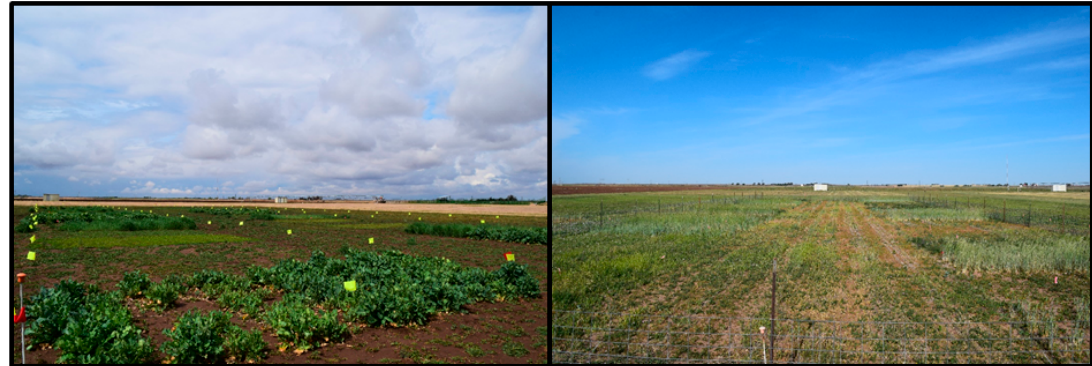
Figure 6. View of cover crop growing in the experimental plot area in Year 1 (spring 2016; left ) and Year 2 (spring 2017; right ). Crops grown included: rye (cv. Maton II), wheat ( Triticum aestivum L.; cv. TAM204), burr medic ( Medicago polymorpha L.; cv. Armadillo), hairy vetch (Vicia villosa Roth; cv. Vallana), rape kale ( Brassica spp.; cv. Bayou), and an unplanted fallow.